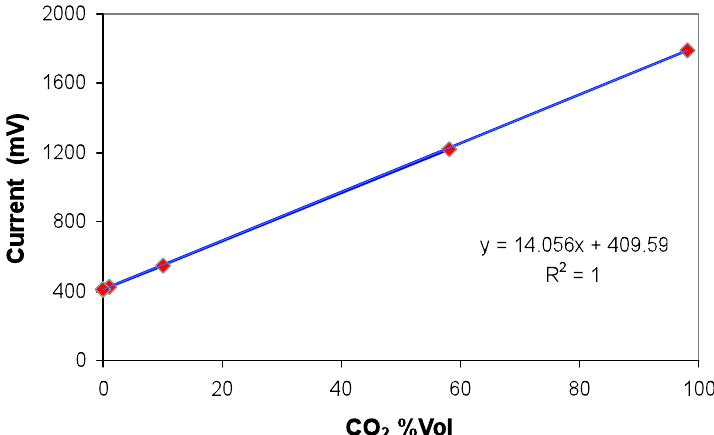
, performed with standards of mixed gases with known CO2